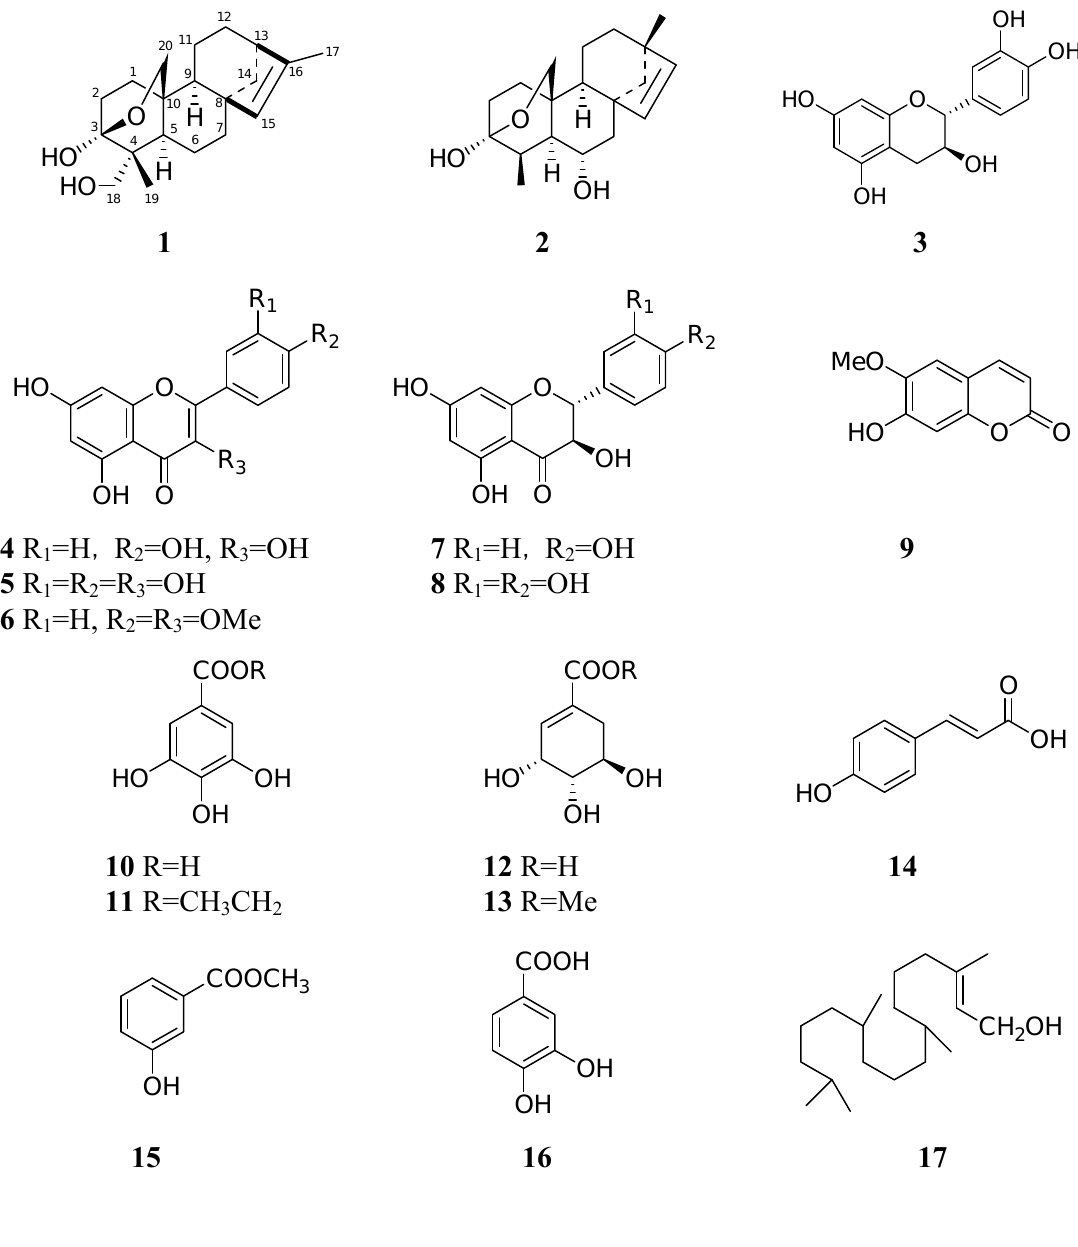
Figure 1. The structures of compounds 1-17